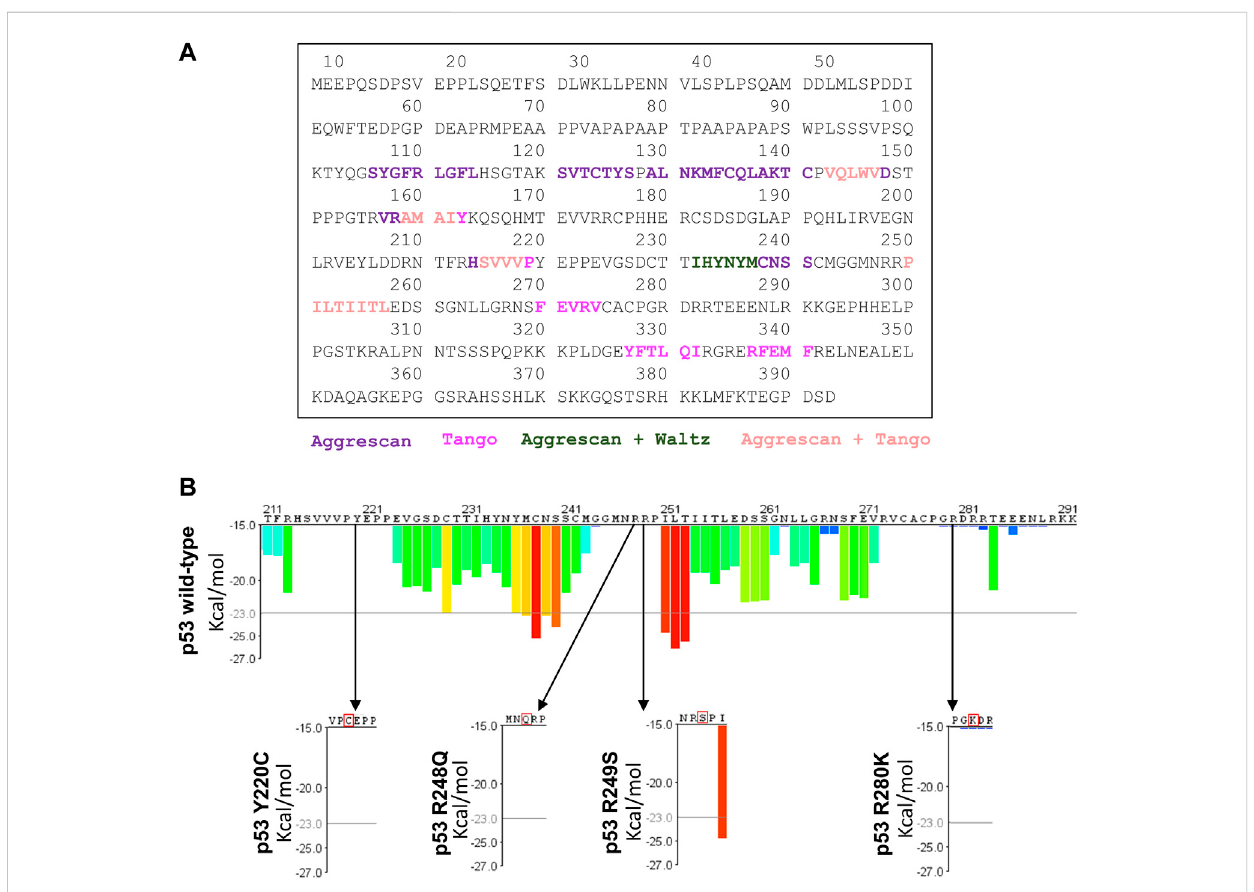
FIGURE 1 Aggregation prediction for p53 mutants using different algorythms. Primary sequence of p53 and aggregation hotspots colored for each aggregation prediction parameter. (A) Mutant p53 sequencesY220C,R249S,R248Q,and R280K withthe highestaggregation-prone sequences colored in purple (AGGRESCAN), violet (TANGO), dark green (AGGRESCAN + WALTZ), and light pink (AGGRESCAN + Tango). (B) Representation of the Rosetta energy for the aggregation-prone segments in the p53 sequence predicted by